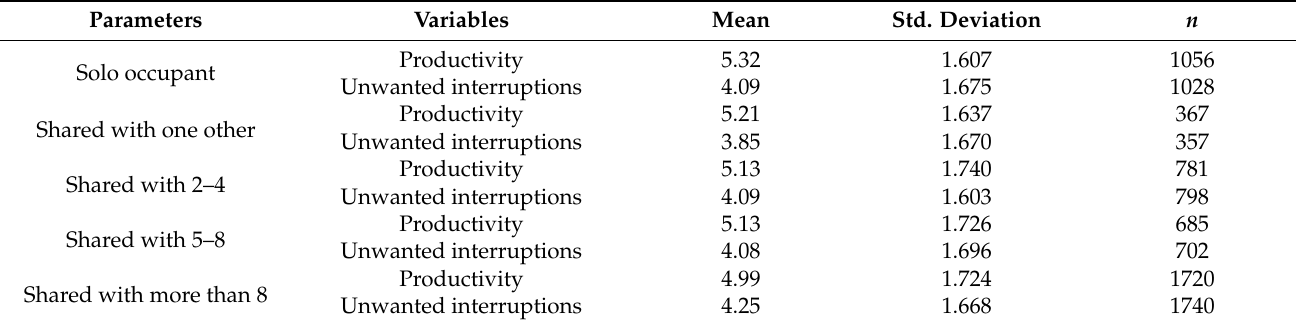
Table 16. Descriptive statistics of productivity and unwanted interruptions for different